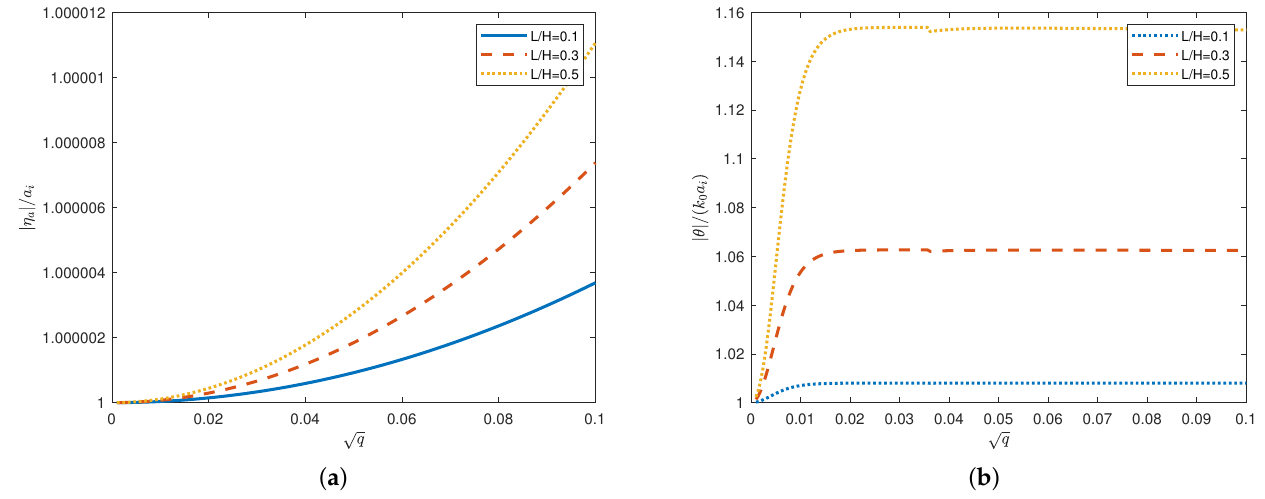
Figure 4. The dimensionless amplitudes of the heave ( a ) and pitch ( b ) motions of the rigid plate for √ q and different length of the rigid plate ˜ small dimensionless frequency